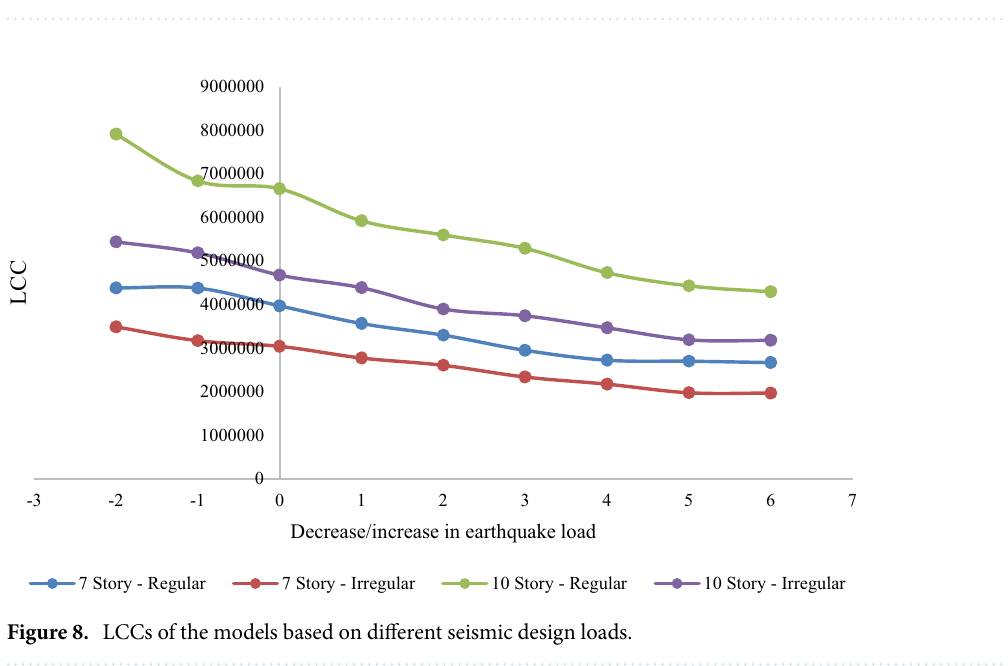
Table 7. Results of 10-story irregular structures under different seismic loads.